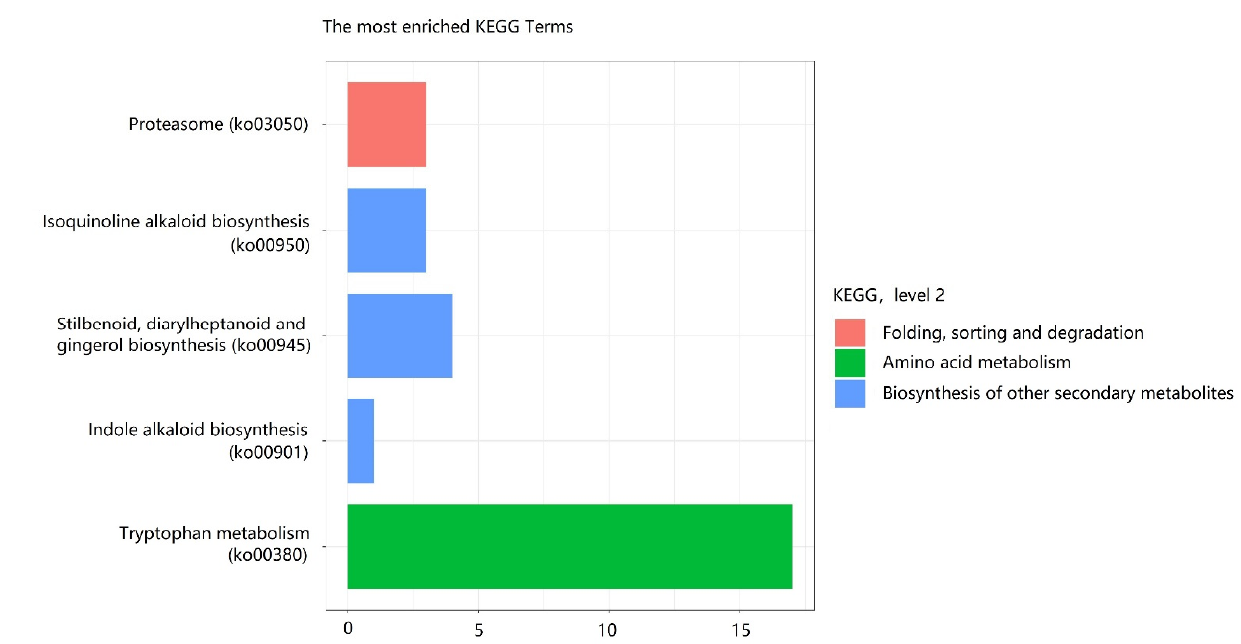
Figure 6. Significantly enriched pathways in KEGG pathway analysis of expressed insect-defense response genes. The DEGs were used to identify enriched biological pathways. These are statistically significant ( p < 0.05) subcategories among the KEGG